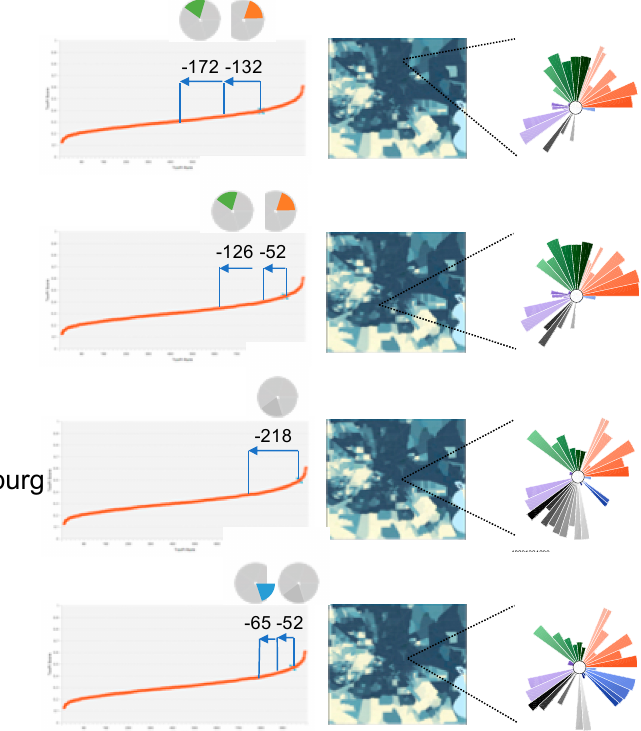
Figure 5. Sensitivity analysis results of simulated rank improvements after ameliorating vulnerabilities in a single domain. The histogram inset shows the overall distribution of ToxPi scores (one per tract), with the top 25th percentile of tracts shaded in the right tail. Among these census tracts, the rank improvement was calculated in our simulated experiments of addressing measures within a single domain, and the results across tracts are shown in boxplots for each domain.